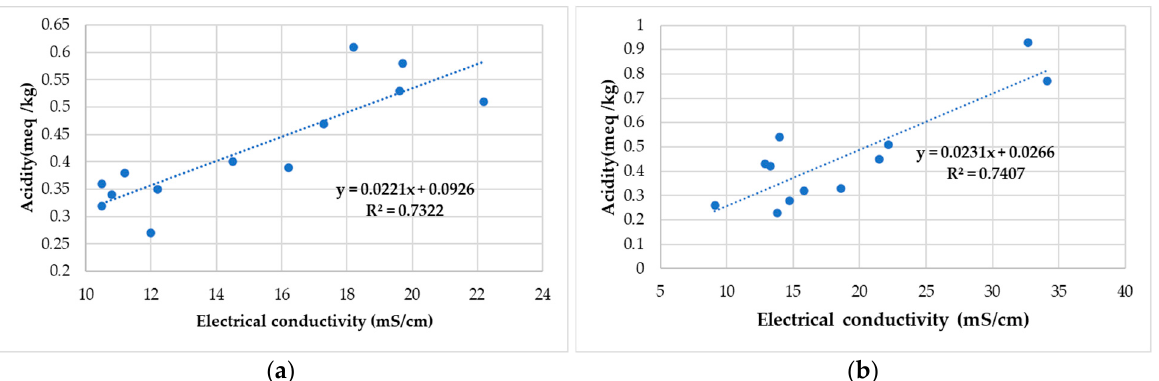
Figure 1. Correlation between acidity and electrical conductivity for polyfloral honey samples ( a ) from North-West and Central Romania and ( b ) from Alba County.